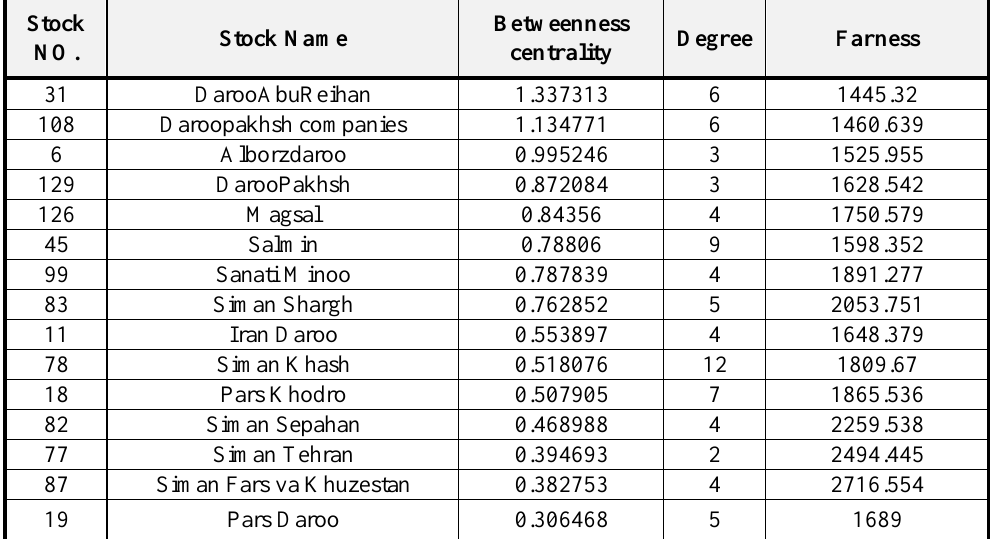
Table 2. Indicators' power criteria